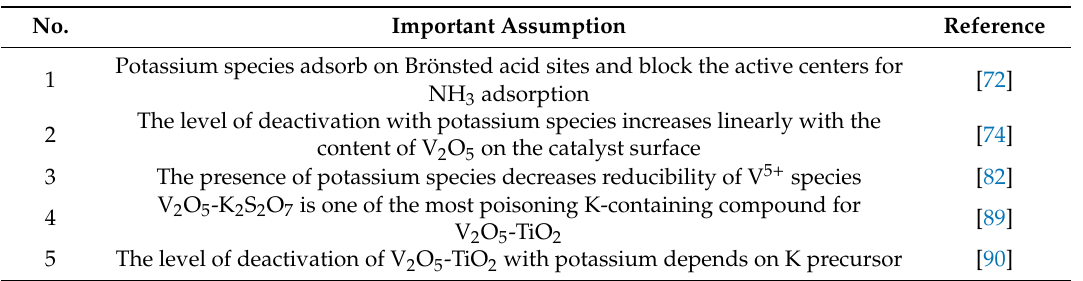
Table 2. The most important findings on the interaction of potassium with V 2 O 5 -TiO 2